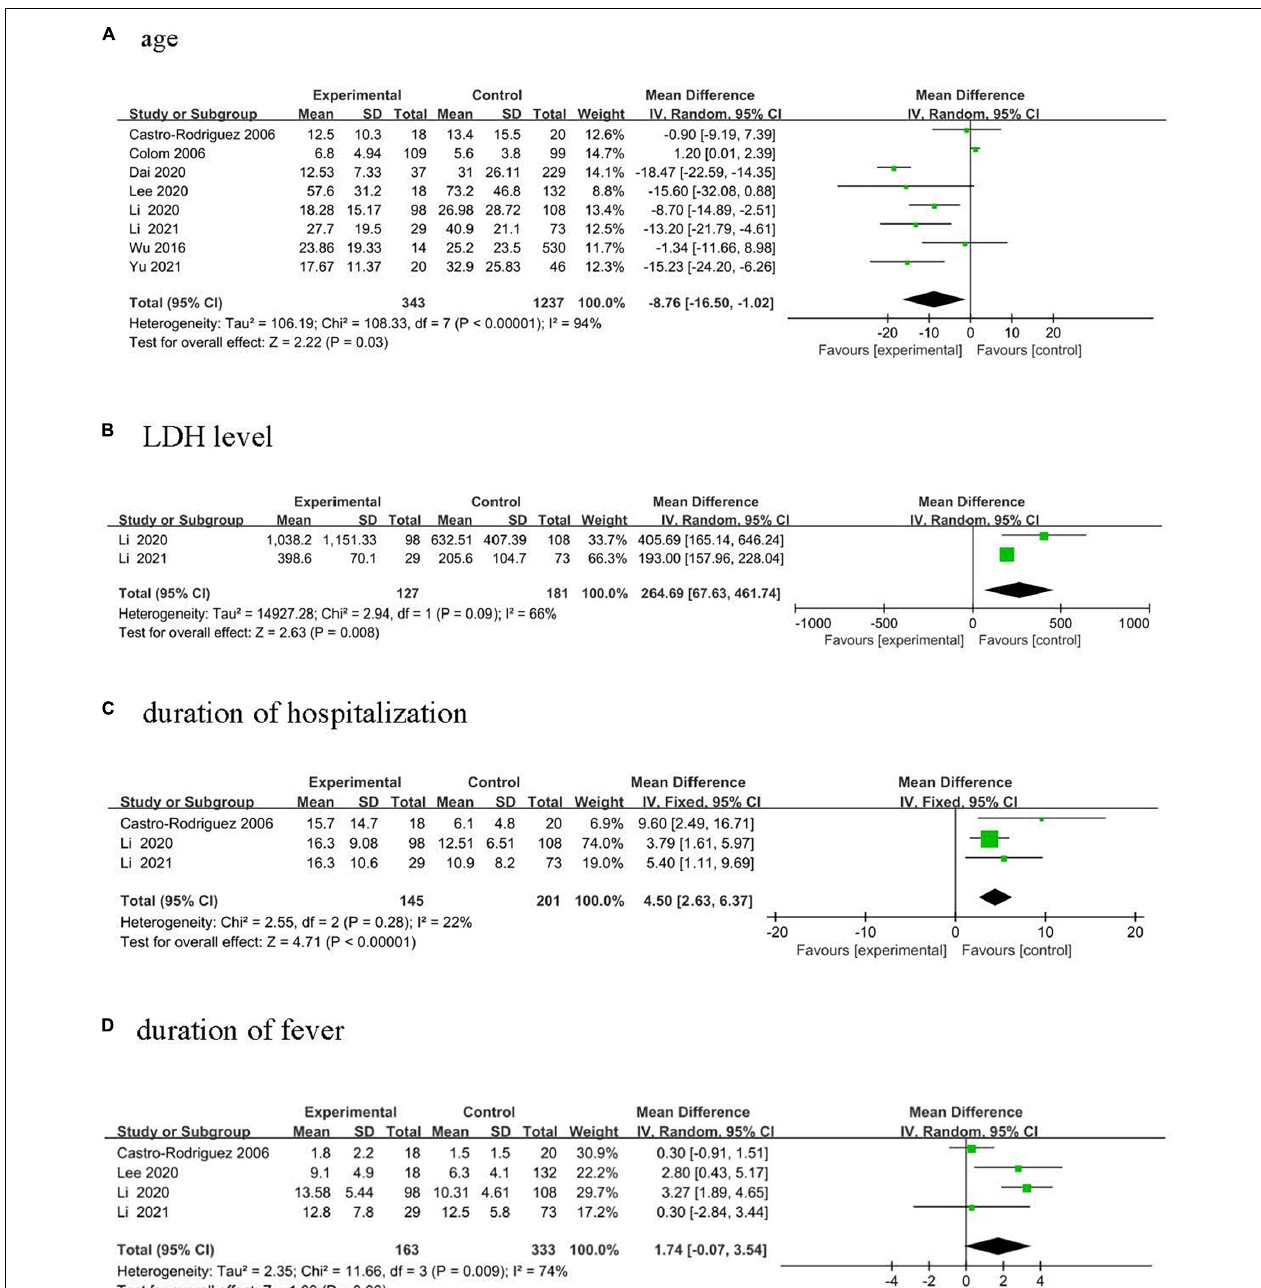
FIGURE 2 | Forest plots of MD estimates for the following risk factors: (A) age; (B) LDH level; (C) duration of hospitalization; and (D) duration of fever.